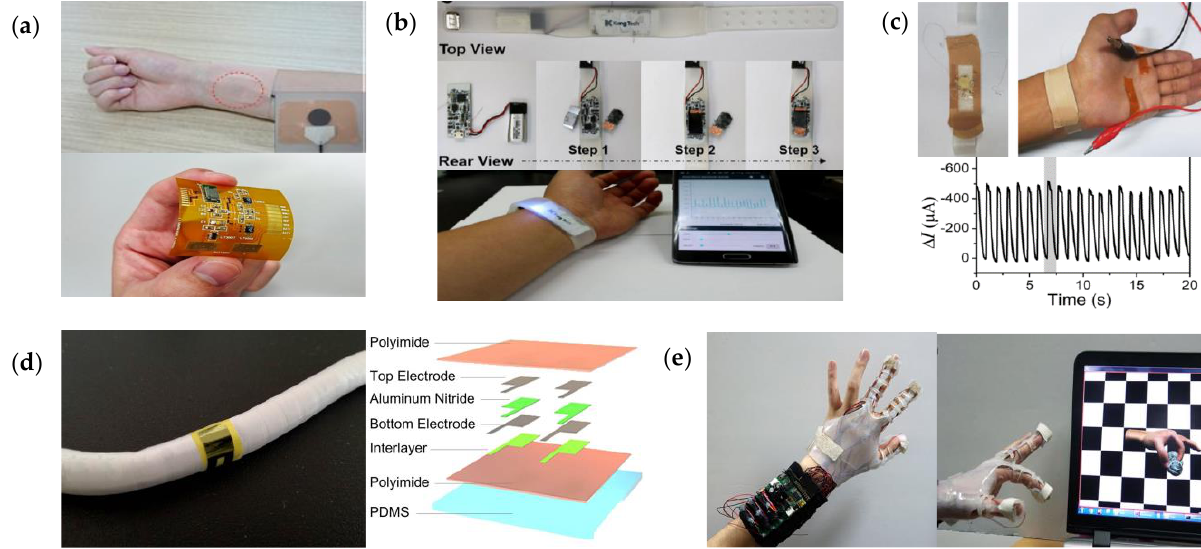
Figure 7. Some representative piezoelectric pressure sensors and applications. ( a ) Skin-compatible adhesive wireless sensing patch (upper) with vital sensor for pulse wave and a measuring wireless sensing system (Bottom) (Reprinted with permission from ref. [86]. Copyright 2014 Royal Society of Chemistry); ( b ) A prototype blood pressure sensor embedded in a wrist band (upper) for diagnostic and display (Bottom) (Reprinted with permission from ref. [72]. Copyright 2018 The Authors); ( c ) A flexible piezoelectric pressure sensor (upper) for the measurement of wrist pulses in 20 s real-time record (Bottom) (Reprinted with permission from ref. [85]. Copyright 2017 American Chemical Society); ( d ) A flexible smart patch sensor (left) with heterostructure (right) for the hemodynamics parameter monitoring (Reprinted with permission from ref. [96]. Copyright 2019 The Authors); ( e ) The integrated glove (left) with a sensor and actuator and actual operation (right) (Reprinted with permission from ref. [97]. Copyright 2019 The